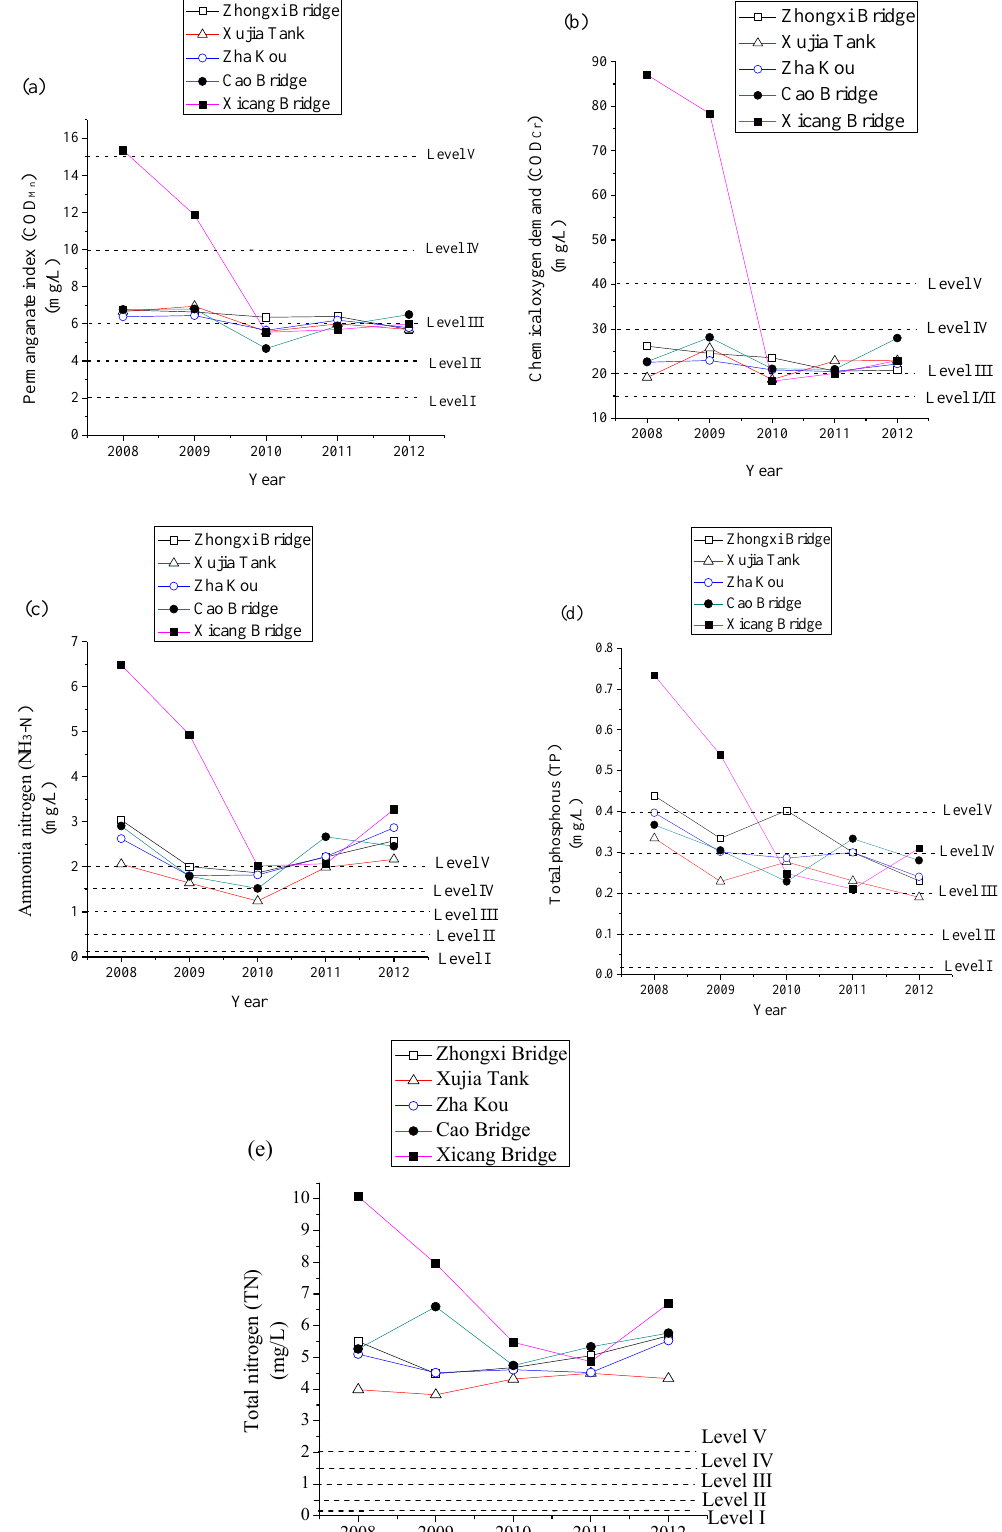
Figure 2. Yearly water quality of five monitoring stations in Caoqiao River. ( a ) Permanganate index, ( b ) Chemical oxygen demand, ( c ) Ammonia-nitrogen, ( d ) Total phosphorus, and ( e ) Total nitrogen.